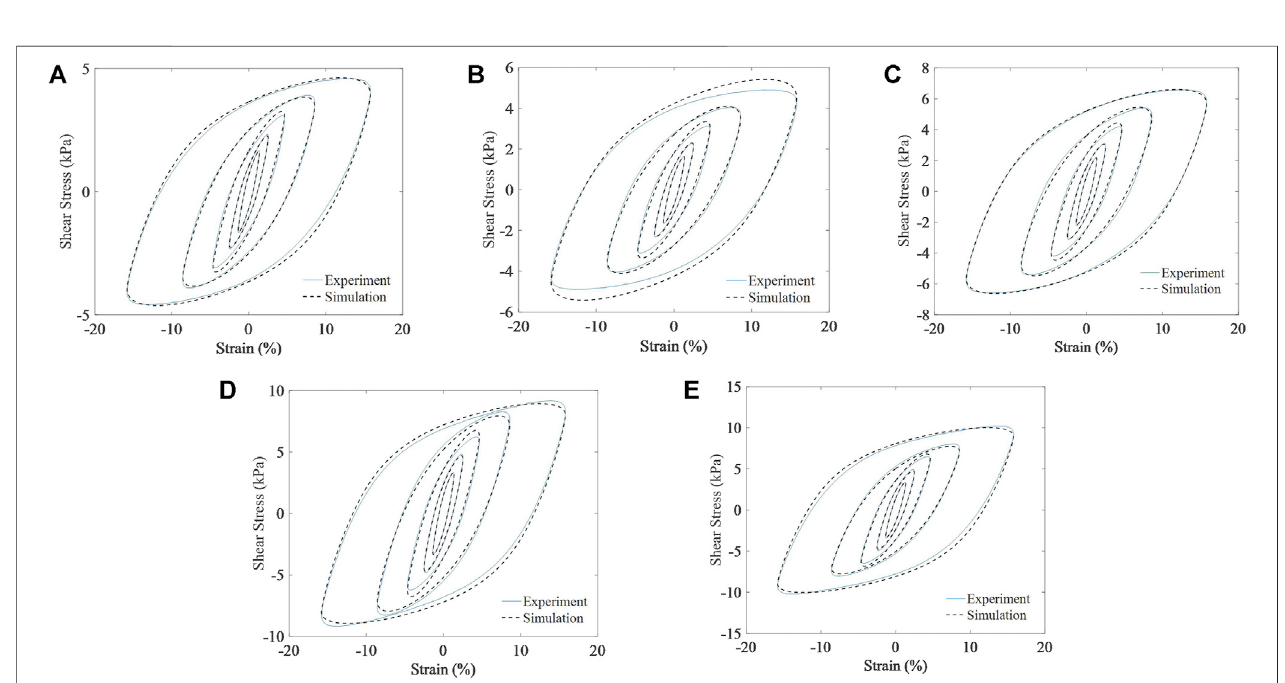
FIGURE 12 | Simulation data and experimental data under identi fi cation conditions: (A) 0 mT, (B) 115 mT, (C) 234 mT, (D) 456 mT, and (E) 545 mT.